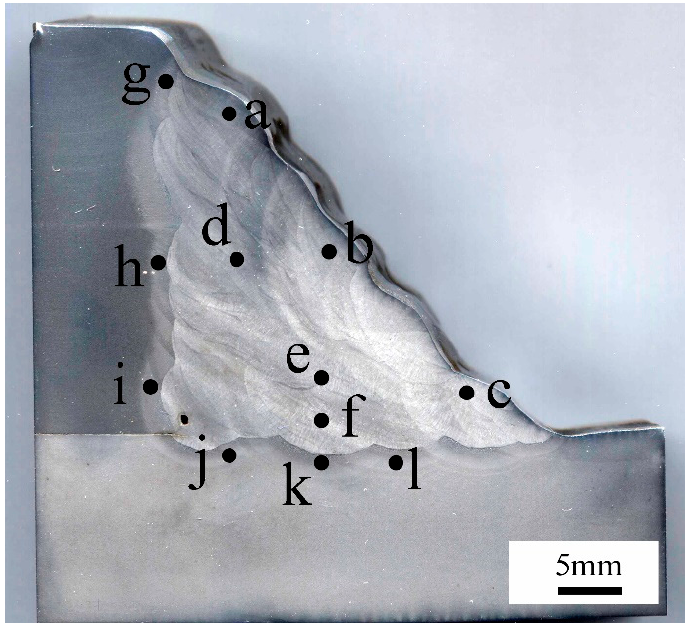
Figure 13. Hardness test point distribution (a–l marked the hardness test points).